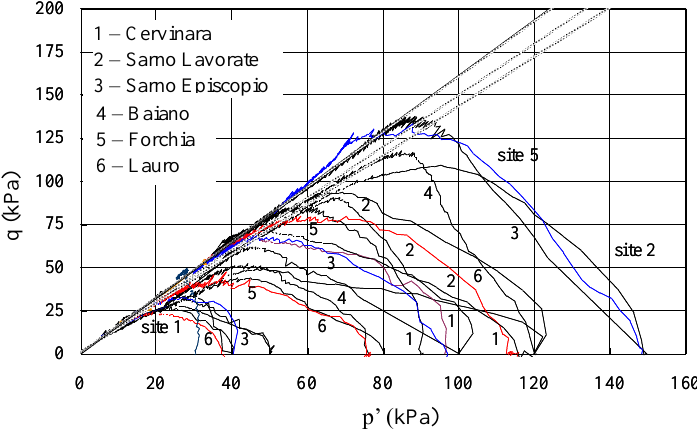
Figure 3. Results of undrained triaxial compression tests on undisturbed specimens of saturated air-fall volcanic ashes from six different sites in Campania.